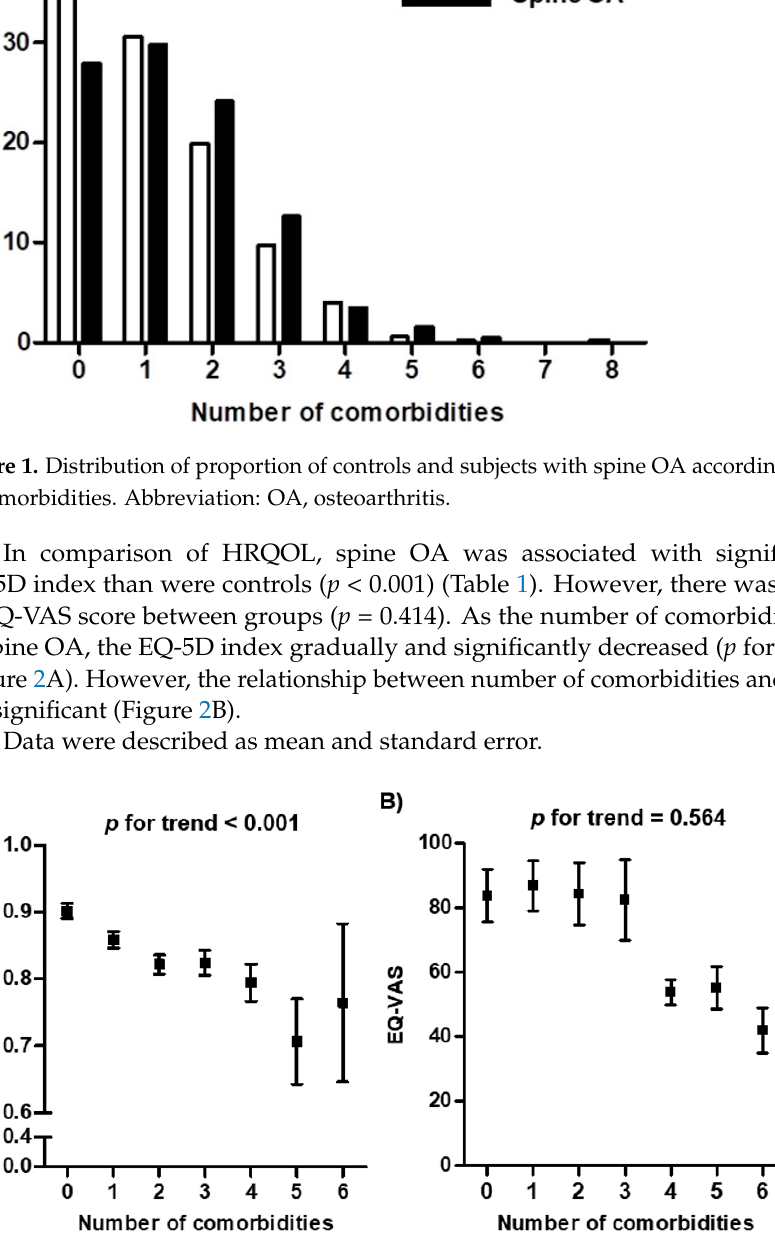
Figure 2. Distribution of health-related quality of life according to the number of comorbidities in subjects with spine OA ( A ) EQ-5D index according to comorbidities. ( B ) EQ-VAS according to comorbidities. Abbreviation: EQ-VAS score, EuroQOL visual analogue scale scores; EQ-5D index, EuroQOL-5dimension index.